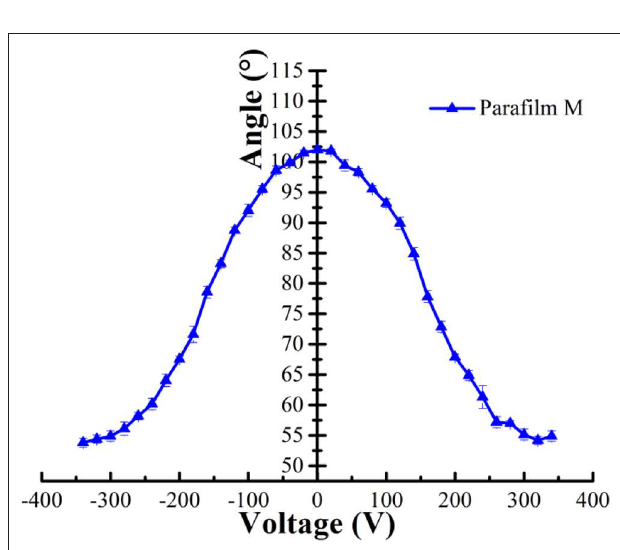
FIGURE 8 | Electrowetting characteristic curve of the Parafilm M.